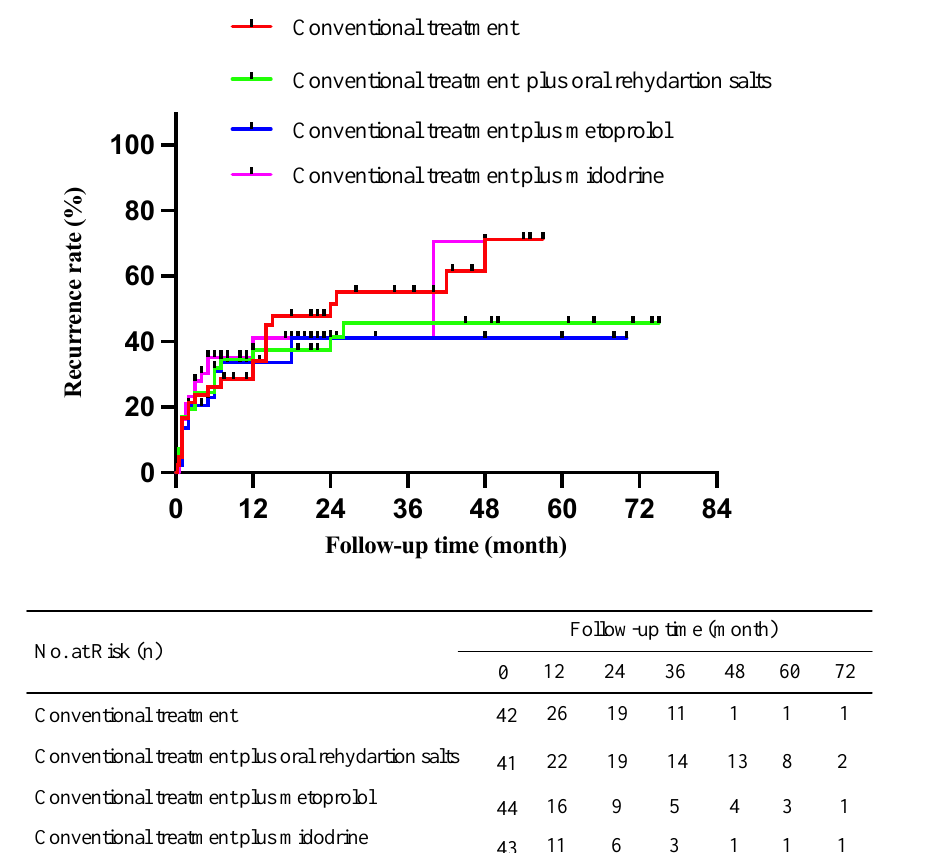
Figure 3. Kaplan – Meier curve analysis with the log-rank test for the recurrence of vasovagal syn- cope in different treatment groups. The mean follow-up time was 20 (8, 42) months. Overall, 23/42 (55%) cases in the conventional treatment group, 17/41 (41%) cases in the conventional treatment plus oral rehydration salts group, 15/44 (34%) cases in the conventional treatment plus metoprolol group, and 17/43 (40%) cases in the conventional treatment plus midodrine hydrochloride group had a syncopal or presyncopal recurrence . χ 2 = 1.328 , p = 0.723.